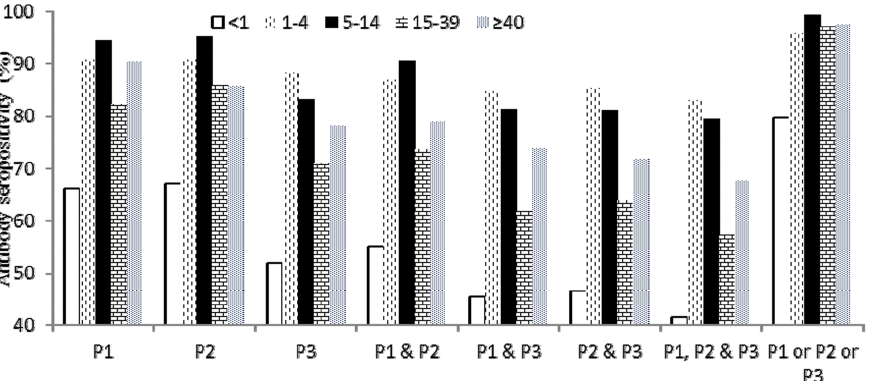
Figure 2. Antibody seropositivity of single serotype and combined serotypes by age group in southern Xinjiang Uygur Autonomous Region before SIAs, 2011. Note: P1: poliovirus serotype 1; P2: poliovirus serotype 2; P3: poliovirus serotype 3.